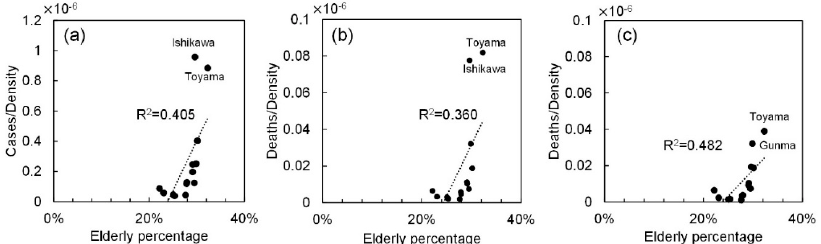
Figure 3. Correlation between the number of confirmed positive cases and fatality normalized by the population density and the percentage of the elderly population. The number of ( a ) positive cases, confirmed deaths ( b ) including and ( c ) excluding those caused by nosocomial infection.